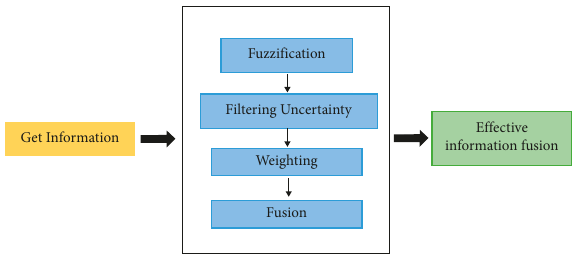
Figure 1: The structure of